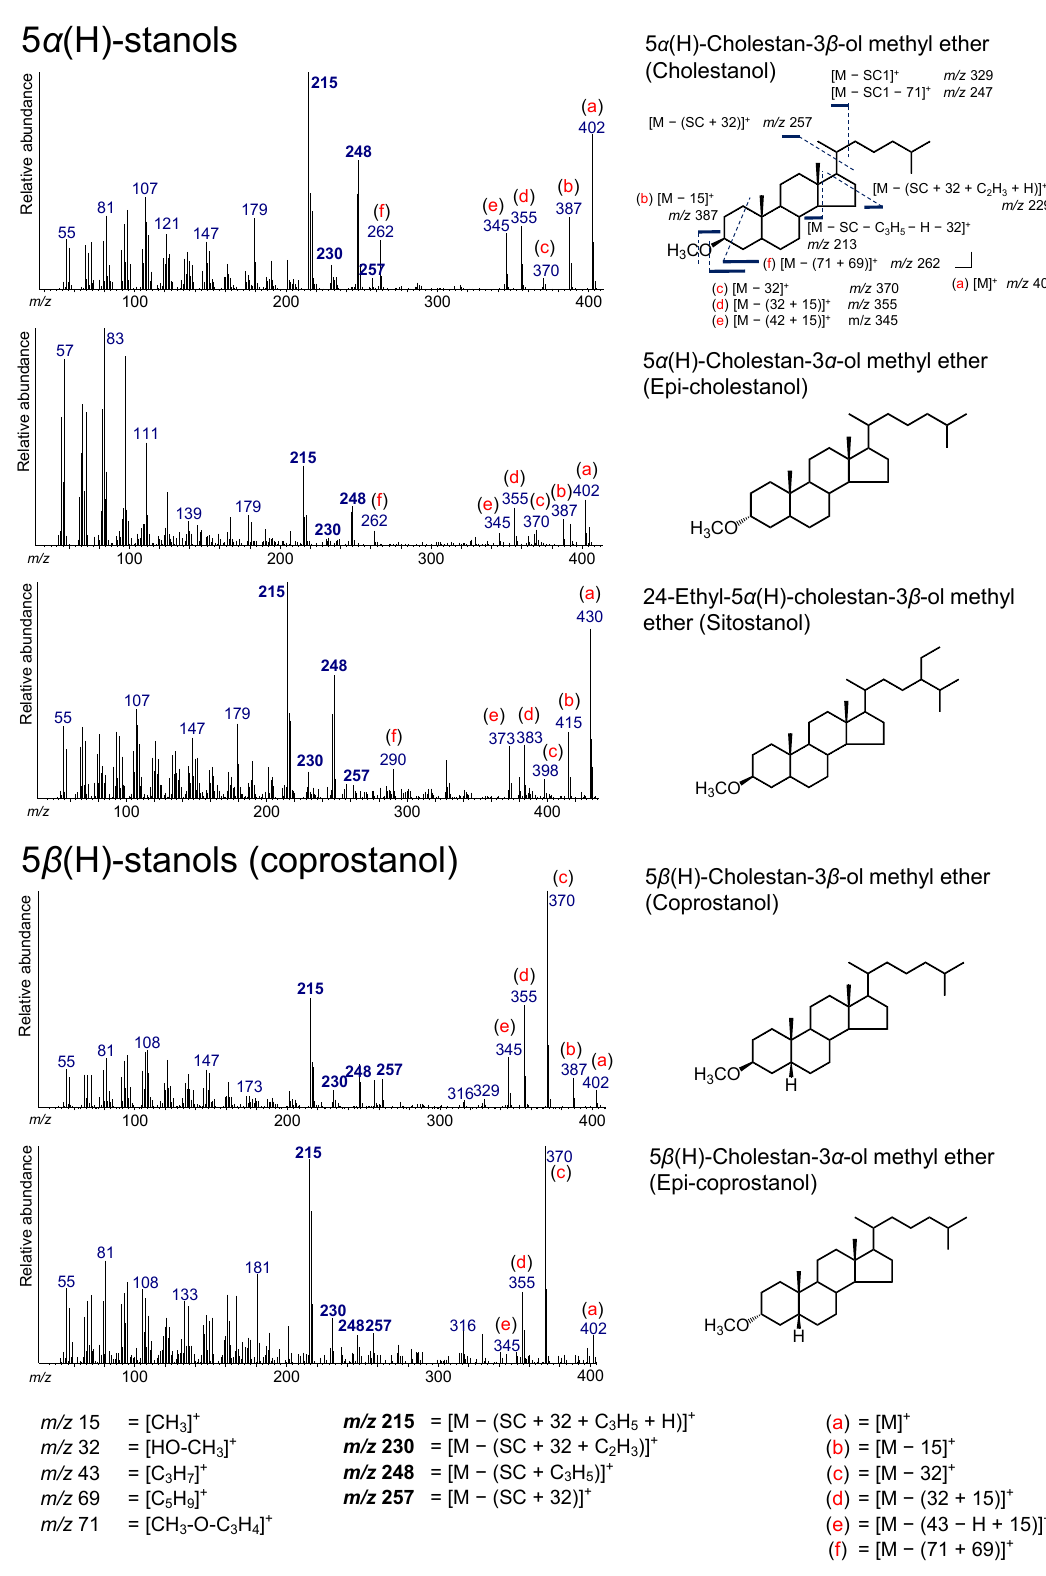
Figure 6. Electron ionization mass spectra of 5 α (H)-stanol and 5 β (H)-stanol (coprostanol). Bold numbers indicate an ion that accompanies the cleavage of the side chain. ( a )–( f ) Ions that not accompanied by the loss of the side chain or other